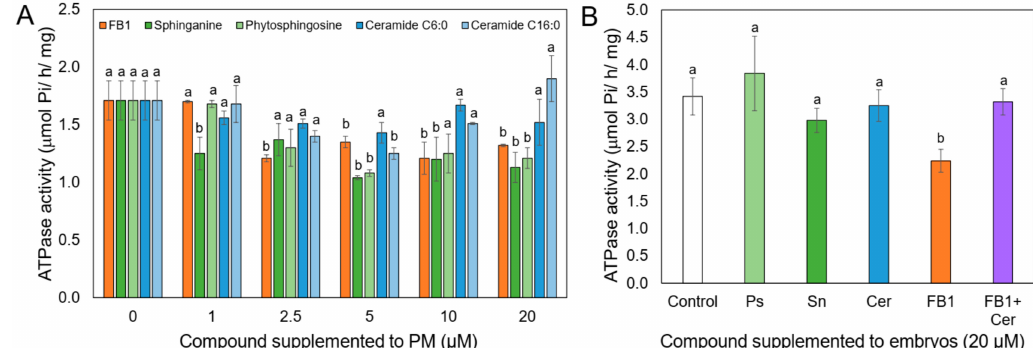
Figure 5. E ff ects of FB1, sphinganine, phytosphingosine, Ceramide C6:0 and C16:0 on the H + -ATPase activity when added to the isolated PM or to the maize embryos. ( A ) Maize embryos were imbibed in the absence of FB1 for 24 h, then PM were purified and exposed to each compound at the indicated concentrations. Five to 10 µ g of membrane protein were used to assay ATP hydrolysis. Means and SE (n = 3) of enzymatic determinations are expressed, followed by letters indicating whether the concentration of each compound had a significant ( P < 0.05) influence on ATPase activity as determined by the t-student comparison of means. ( B ) Maize embryos were exposed to 20 µ M of every sphingoid compound or FB1 for 24 h. Then, PM vesicles were isolated and ATP hydrolysis measured as phosphate release as described under Materials and Methods. Data are means of three independent experiments ± SD. Two-way ANOVA followed by Bonferroni’s multiple comparisons test and one sample t -test were performed using GraphPad Prism version 8.0 for Windows, GraphPad Software (San Diego,